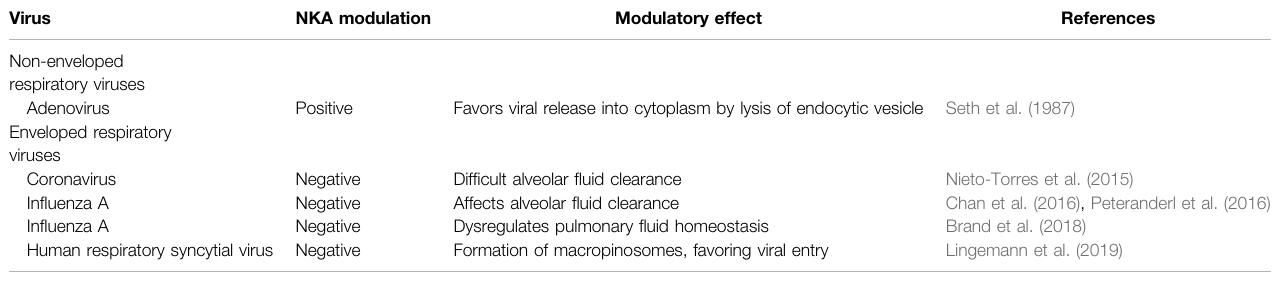
TABLE 1 | Na + /K + -ATPase modulation by respiratory viruses.